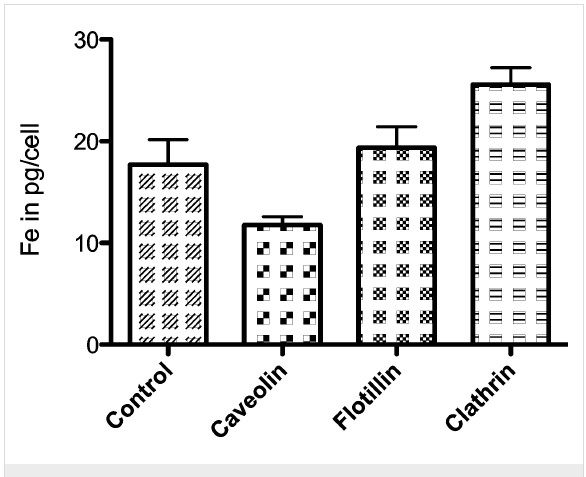
Figure 6: Iron content of control and transfected HeLa cells in pg/cell after 24 h incubation with PEGylated SPIONs; target proteins: Caveolin-1, Flotillin-1, Clathrin (iron concentration 50 µg/mL, error bars: SEM, n =